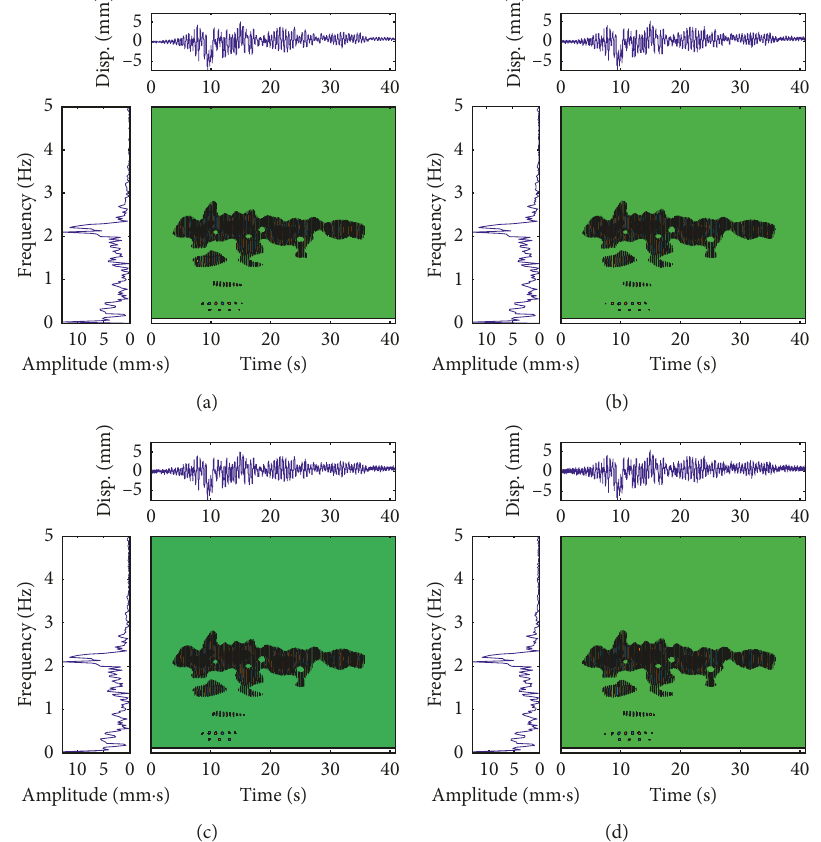
Figure 22: Time histories, TFFs, and the FFTspectra of interstory displacements at Story 1 under different noise levels (Case 5). (a) Noise level of 5%, (b) noise level of 10%, (c) noise level of 15%, and (d) noise level of